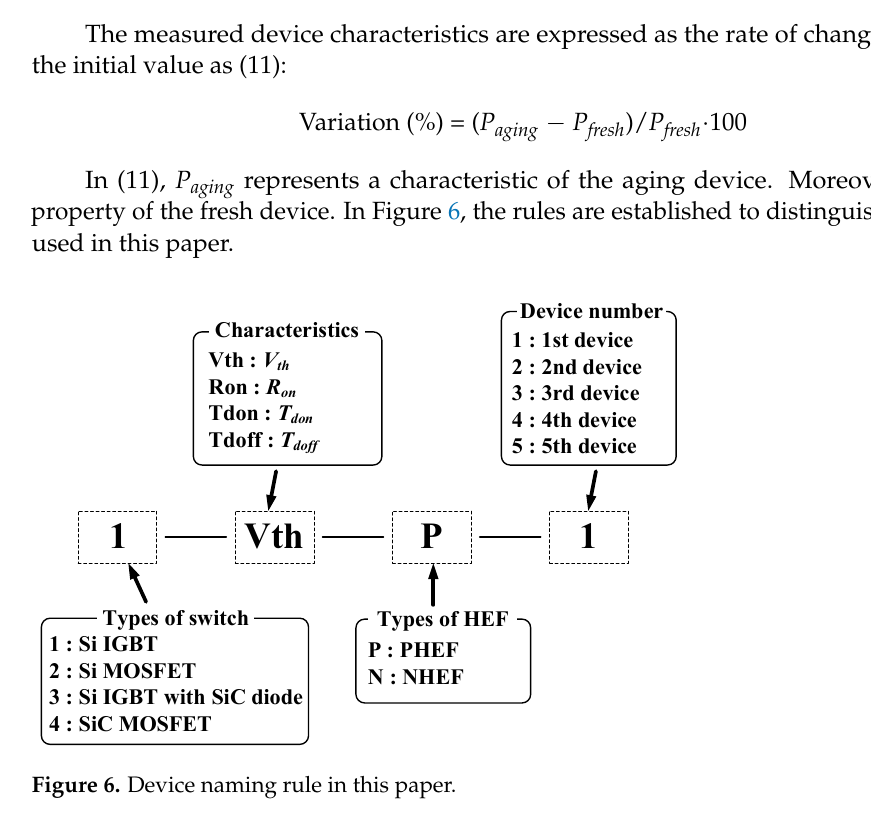
Figure 6. Device naming rule in this paper.